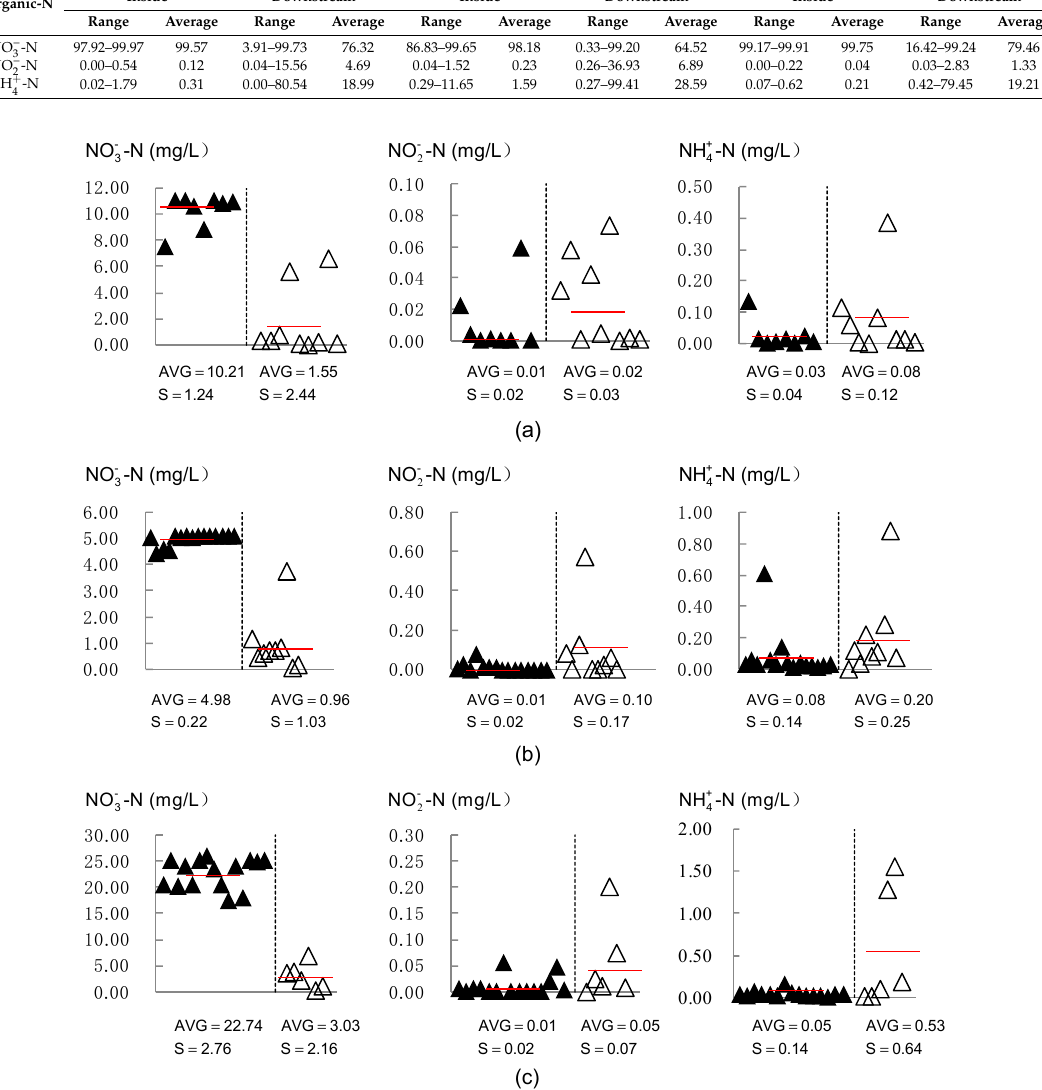
− − -N, NO -N, and NH + -N concentrations in stored water and the -N, NO − -N, and NH + -N concentrations in stored water and 3 2 4 3 2 4